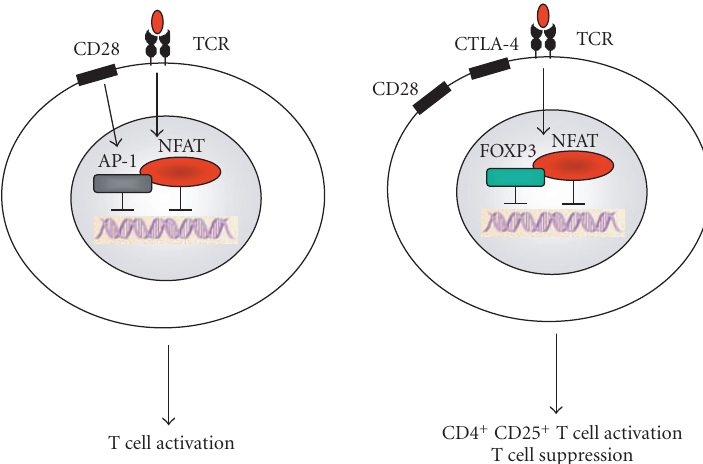
Figure 2: FOXP3 regulates NFAT-mediated gene transcription in CD4 + CD25 + regulatory T cells. In both conventional T cells (left) and CD4 + CD25 + regulatory T cells (right), T cell receptor-(TCR-) mediated activation upregulates the expression of the transcription factor NFAT. Upon TCR stimulation and CD28-mediated costimulation, NFAT binds to AP-1 in conventional T cells but to FOXP3 in CD4 + CD25 + regulatory T cells. As a consequence, activation results in the transcription of a di ff erent set of genes in both cell types.